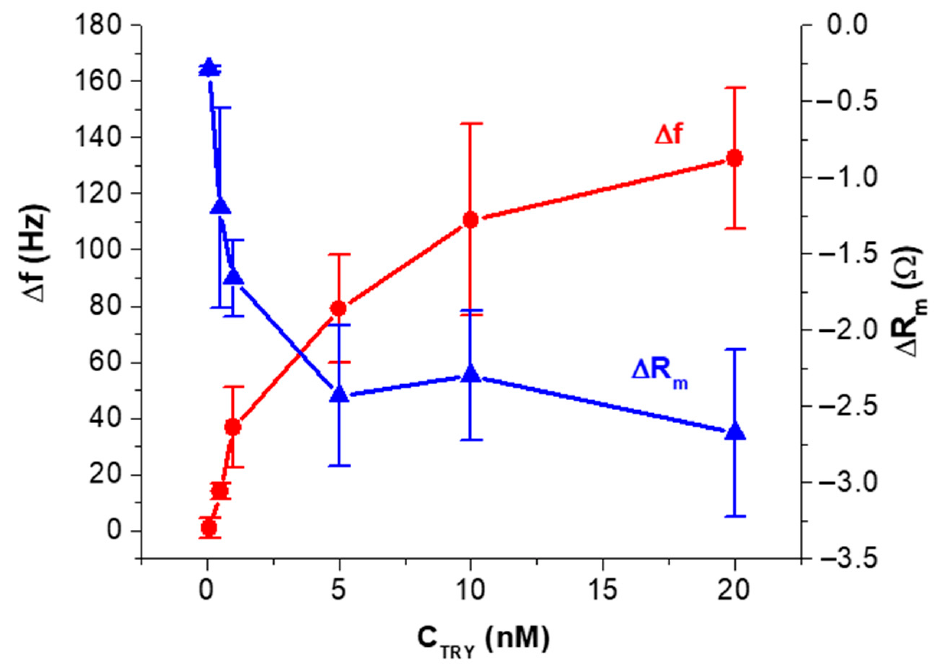
Figure 4. Plots of changes of frequency, ∆ f, and motional resistance, ∆ R m , vs. trypsin concentration (C TRY ). Statistically, a value for the standard deviation was obtained from three independent experiments at each trypsin concentration.